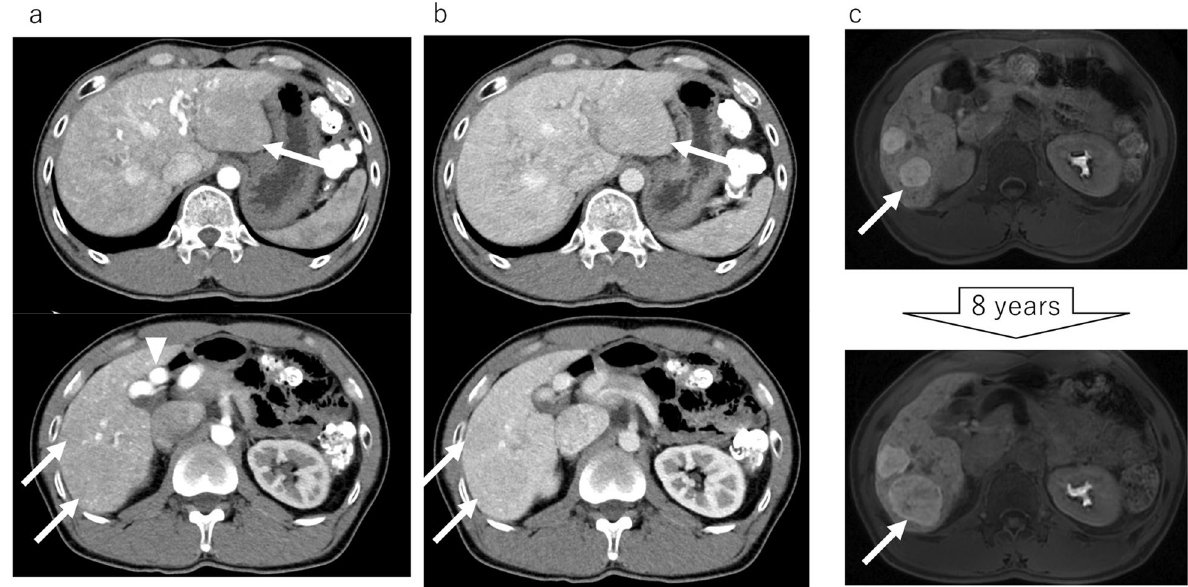
Fig. 1 Preoperative images. At the initial visit, CT showed multiple lesions of up to 75 mm in both lobes of the liver (arrows). In the arterial phase, the common and proper hepatic artery (arrowhead) was markedly dilated and tortuous. The lesions were slightly enhanced, and the liver parenchyma was strongly enhanced from the arterial phase and was very heterogeneous due to small telangiectasias ( a ). In the portal phase, the lesions showed delayed enhancement ( b ). MRI showed that lesions were enhanced in the hepatocellular phase. During 8 years of follow-up, the only lesion to increase in size was a segment 6 lesion (arrow); this tumor increased in diameter from 30 to 50 mm ( c